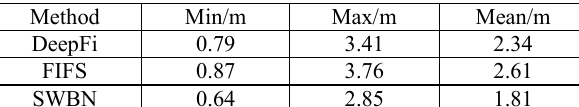
Table 2. Positioning errors of different positioning methods